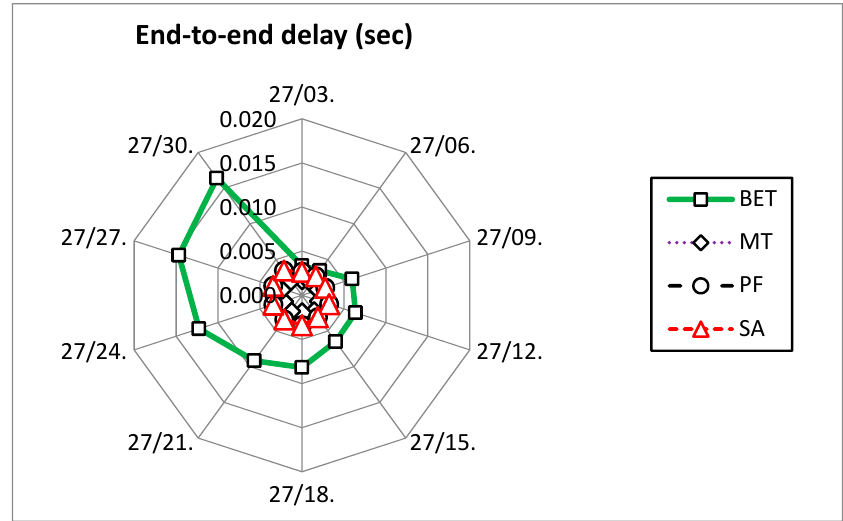
Figure 11. Average packet end-to-end delay for video near users in mixed traffic.